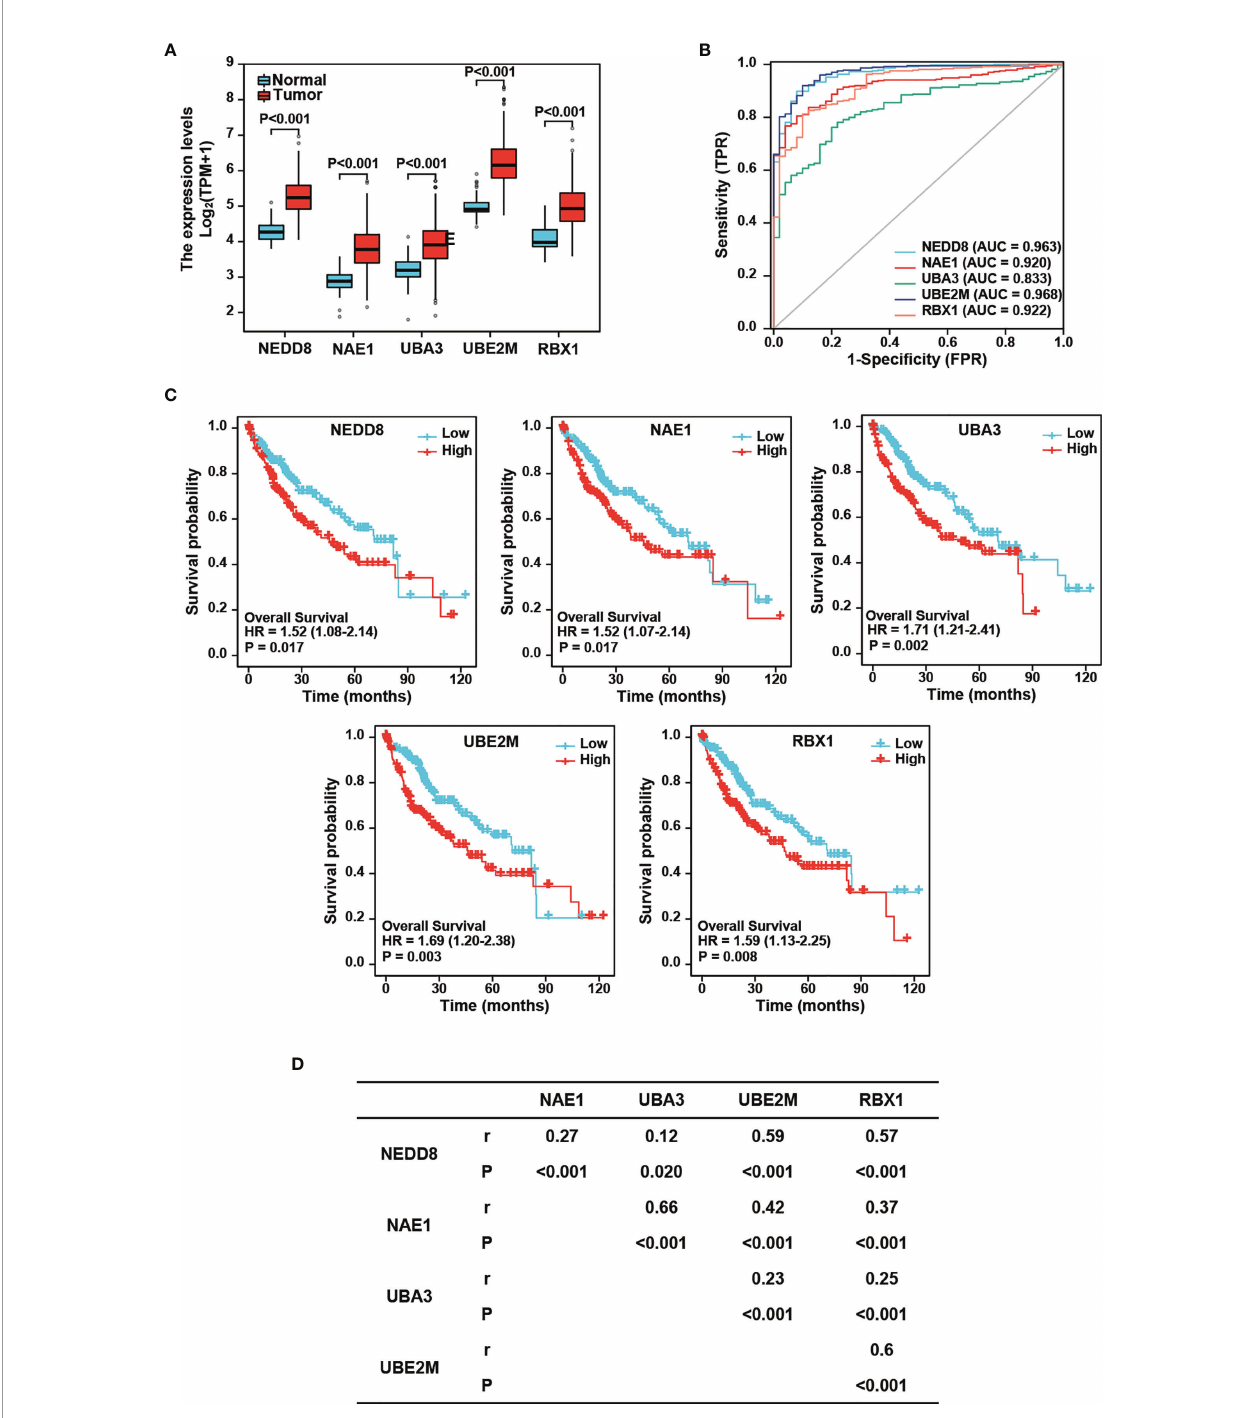
FIGURE 1 | Expression of neddylation pathway components and the prognostic signi fi cance in HCC. (A) mRNA levels of neddylation pathway components are higher in hepatocellular carcinoma tissues compared with normal liver tissues. The RNAseq data in TPM form and clinical information were obtained from TCGA (https://portal.gdc.cancer.gov/) LIHC data. (B) ROC curve analysis of neddylation pathway components. (C) High expression of neddylation pathway components is associated with worse prognosis. (D) Neddylation pathway components positively correlate with each